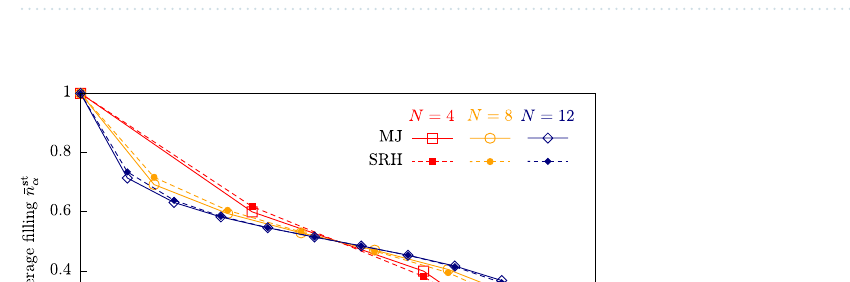
Table 1. Comparison of analytically found stationary trap filling distributions and currents between traps for MJ and SRH models.